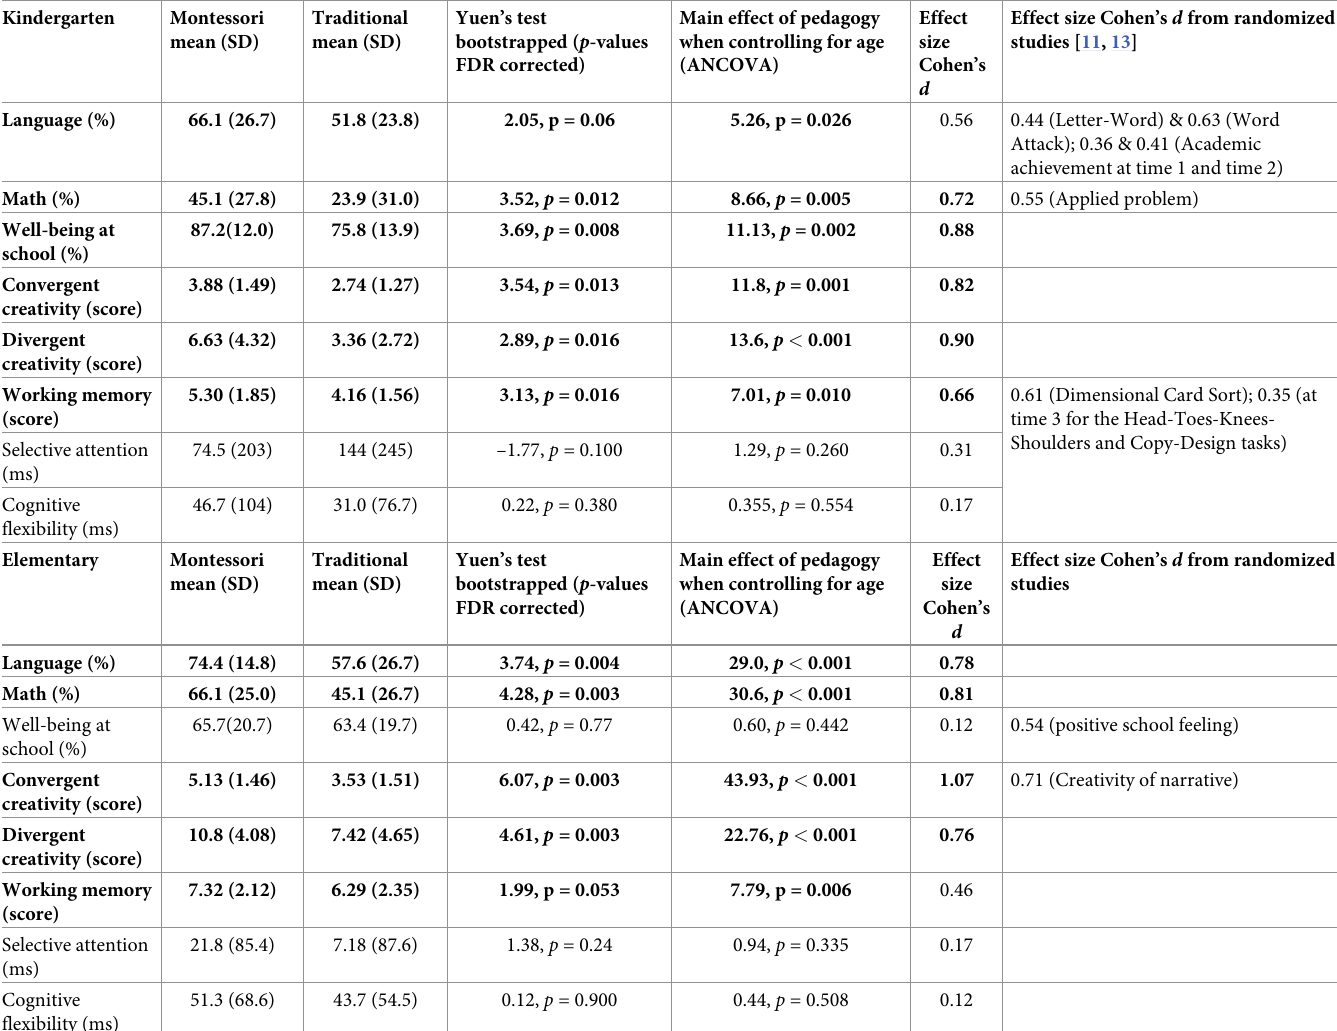
Table 3. Scores per age level and group (mean, SD), and